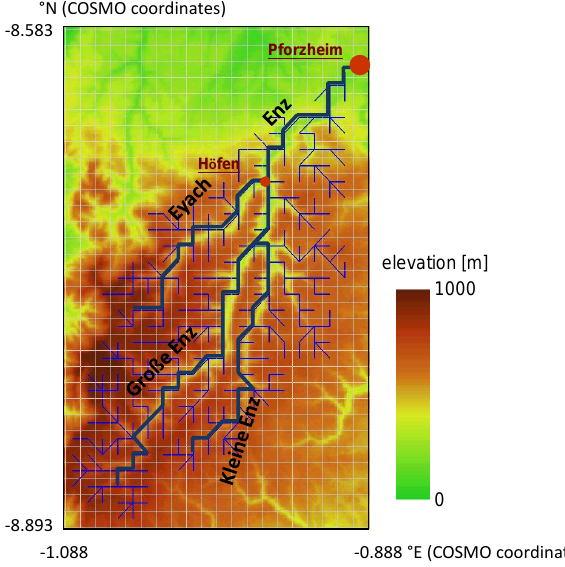
Fig. 2. The orography (based on the 90m-orographic data from the SRTM) and the river network for the Enz catchment upstream of Pforzheim on the rotated spherical coordinate system of the COSMO on a grid resolution of 0.01 ◦ ( ≈ 1km).